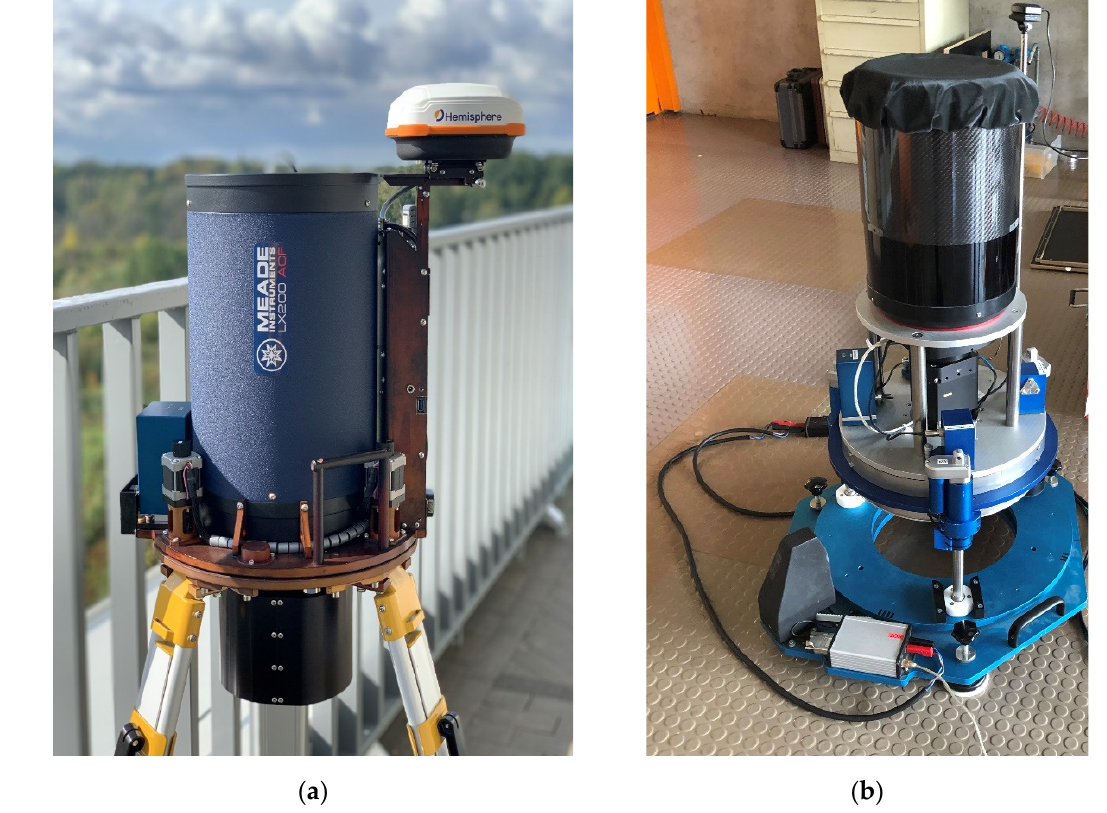
Figure 1. ( a ) VESTA [24] and ( b ) CODIAC digital zenith cameras (DZCs).